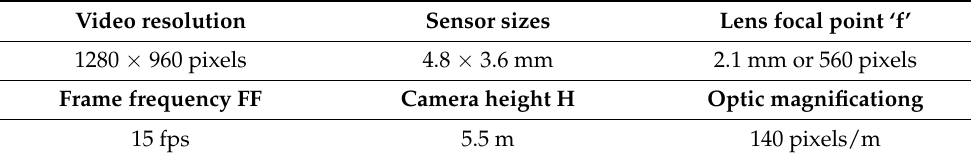
Figure 12. Location of the bottom of the detected objects. Table 5. Experimental conditions and optic Table 5. Experimental conditions and optic parameters.